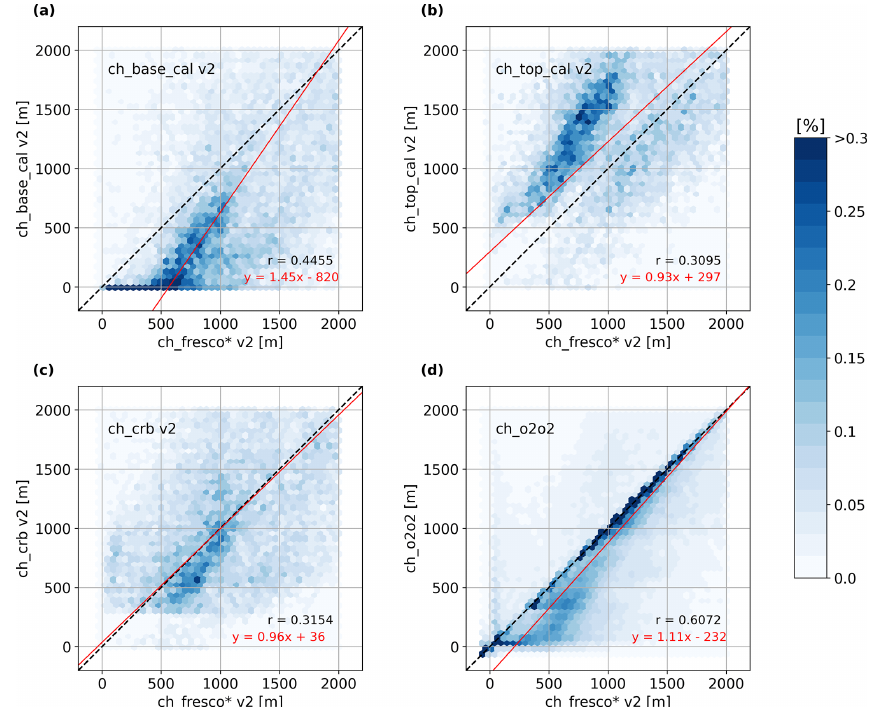
Figure 15. As Fig. 14 but only for cloud heights lower than or equal to 2km (only CH ≤ 2km for scenes with cloud fractions ≤ 0.2).